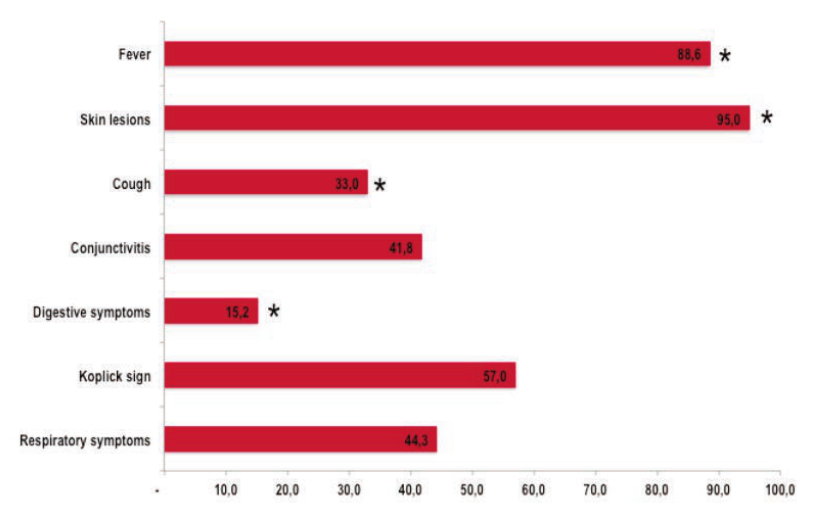
Figure 5. Proportion of symptom follow-up reported during the measles outbreak,